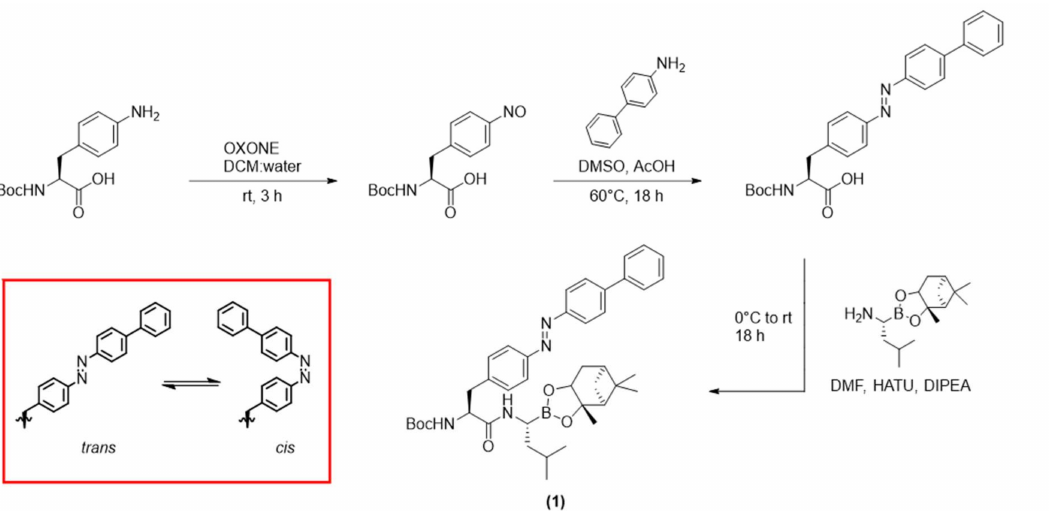
Figure 1. Synthesis of compound 1 (adapted from Ref. [10]) resulting in the trans isomer. (Inset) trans and cis isomers of azobenzene, displayed as substructures of compound 1